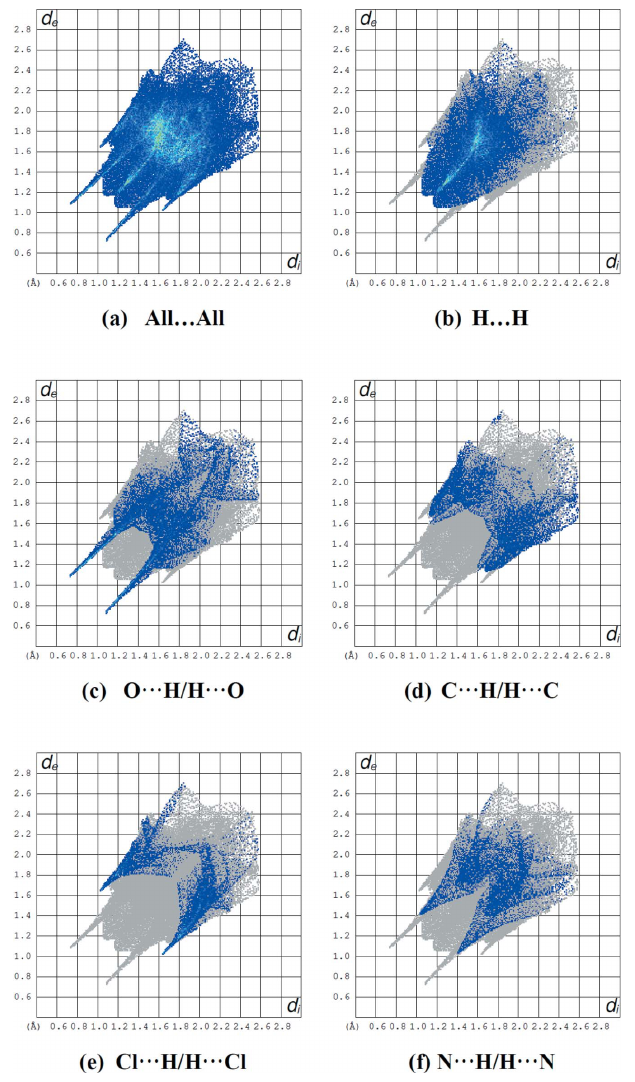
Figure 7 The two-dimensional fingerprint plots of the title compound, showing ( a ) all interactions, and those delineated into ( b ) H (cid:2)(cid:2)(cid:2) H, ( c ) O (cid:2)(cid:2)(cid:2) H/H (cid:2)(cid:2)(cid:2) O, ( d ) C (cid:2)(cid:2)(cid:2) H/H (cid:2)(cid:2)(cid:2) C, ( e ) Cl (cid:2)(cid:2)(cid:2) H/H (cid:2)(cid:2)(cid:2) Cl and ( f ) N (cid:2)(cid:2)(cid:2) H/H (cid:2)(cid:2)(cid:2) N interactions [ d e and d i represent the distances from a point on the Hirshfeld surface to the nearest atoms outside (external) and inside (internal) the surface,